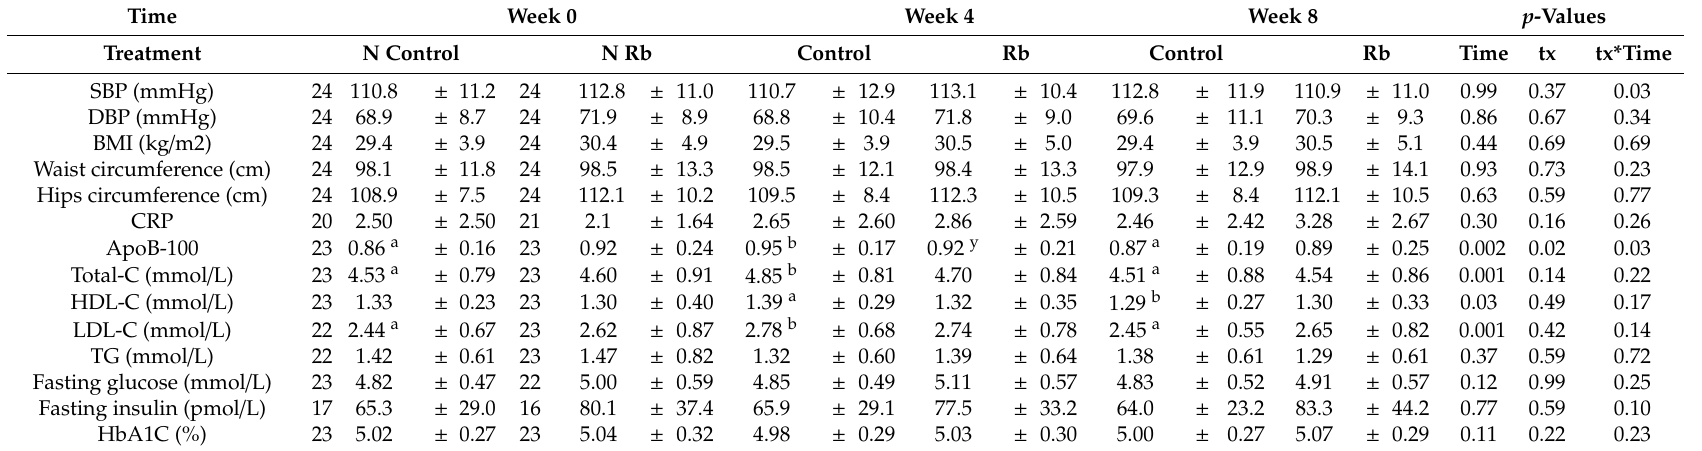
Table 4. Variations of anthropometrics, body composition, and blood pressure parameters over time within and between